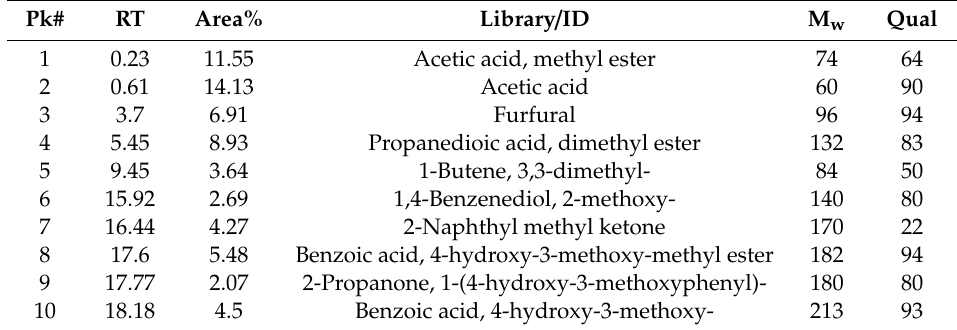
Table 4. Py–GC / MS analysis results for the DKL product from oxidative de-polymerization of HKL at room temperature and 1:1 H 2 O 2 / HKL mass